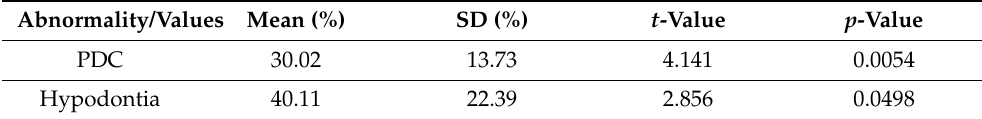
Table 3. Percentage of dental abnormalities in study groups and significance of the difference from general population. Abnormality/Values Mean (%) SD